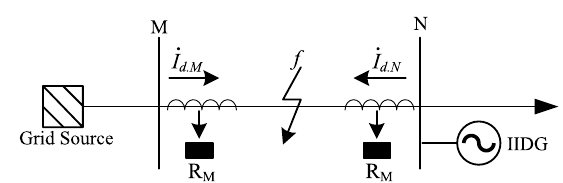
Fig. 6 Simple active distribution